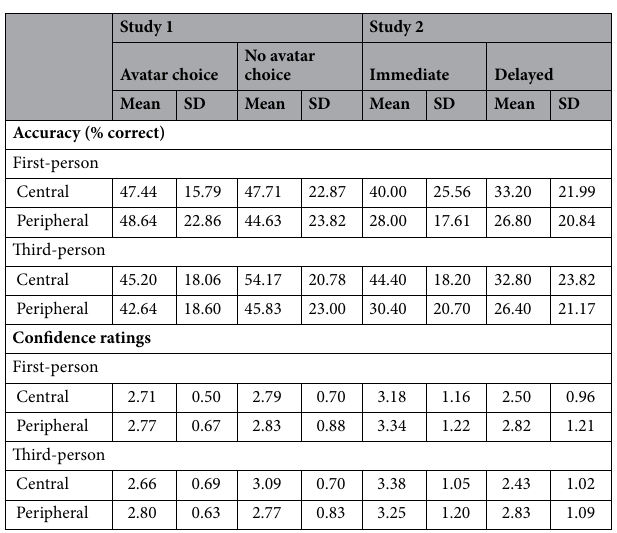
Table 3. Cued-recall memory accuracy and confidence